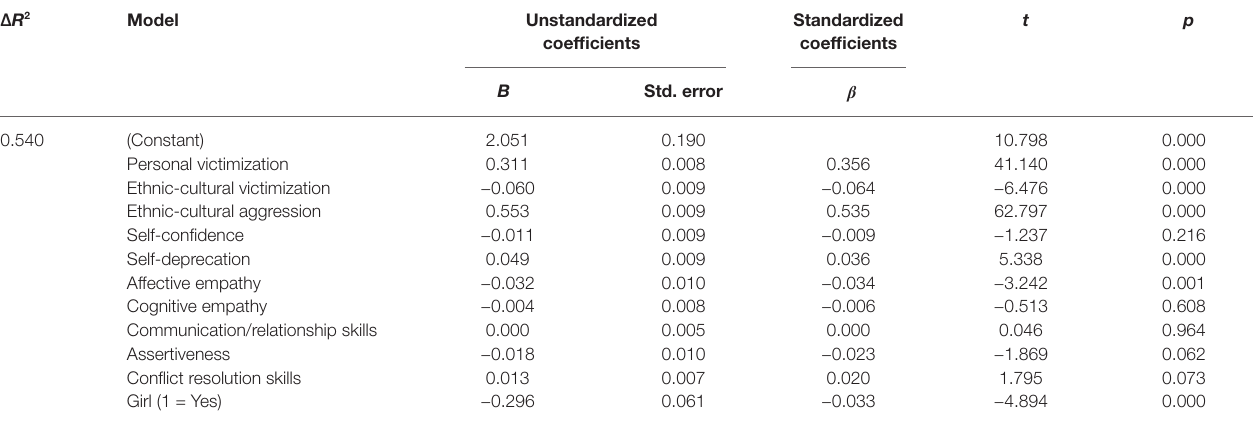
TABLE 4 | Multiple linear regression model for personal aggression (Ecuador). ∆ R 2